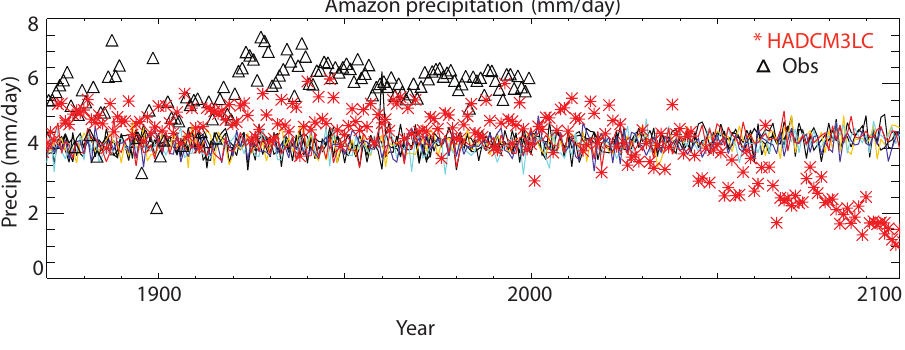
Fig. 13. Precipitation (mmday − 1 ) estimates with time from 1870 to 2100 from model cases (colored lines), observations (black diamonds) and the (Jones et al., 2003) simulations using the HADCM3LC model for the Amazon region (70W–55W,